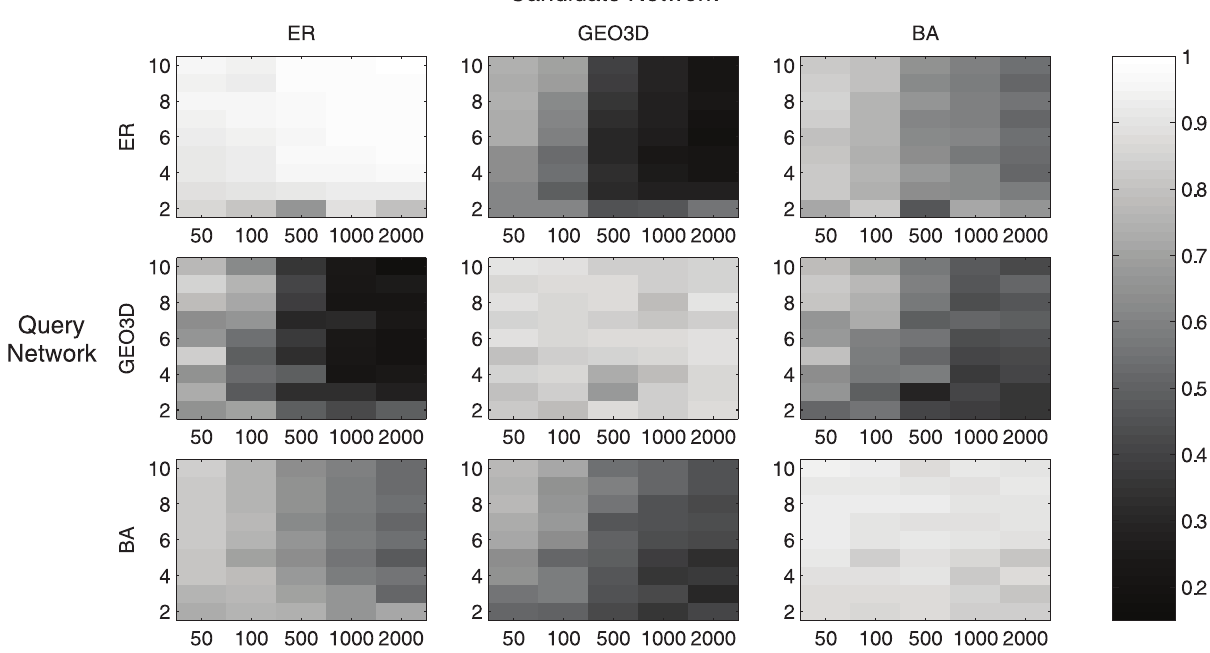
Figure 2. Heat map of average EVSA score in various comparisons. Each subplot represents the heat map of average EVSA score of a single type comparison. For instance, the bottom left subplot is the comparison of Scale-free (SF) network versus Erdos Renyi (ER) network, SF network is the Query Network and ER network is the candidate network. In each subplot, the y-axis represents the average degree, x-axis represents the network size (vertex number) the grey level represents the average EVSA